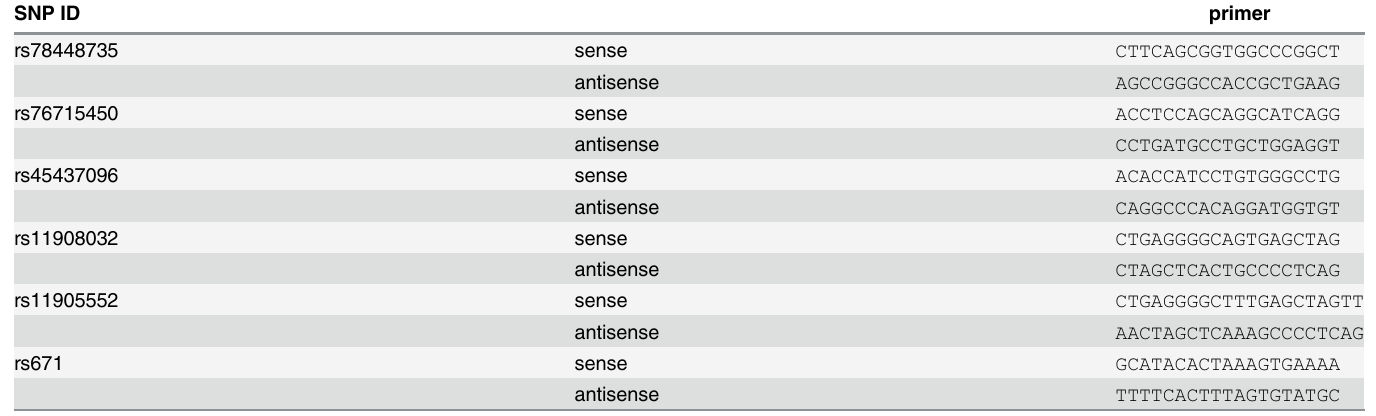
Table 3. Primer sets for the syntheses of SNP-including genomic